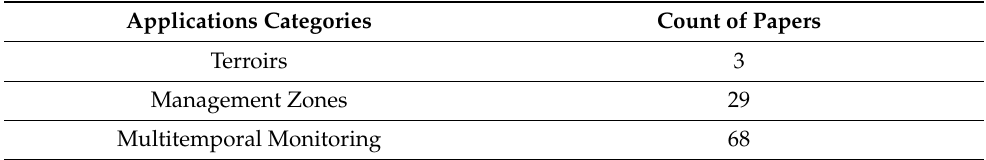
Table 6. Categories of vegetation indices applications.